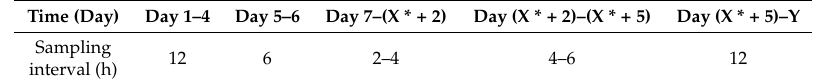
Table 3. Sampling schedule in our tracer test 1 .